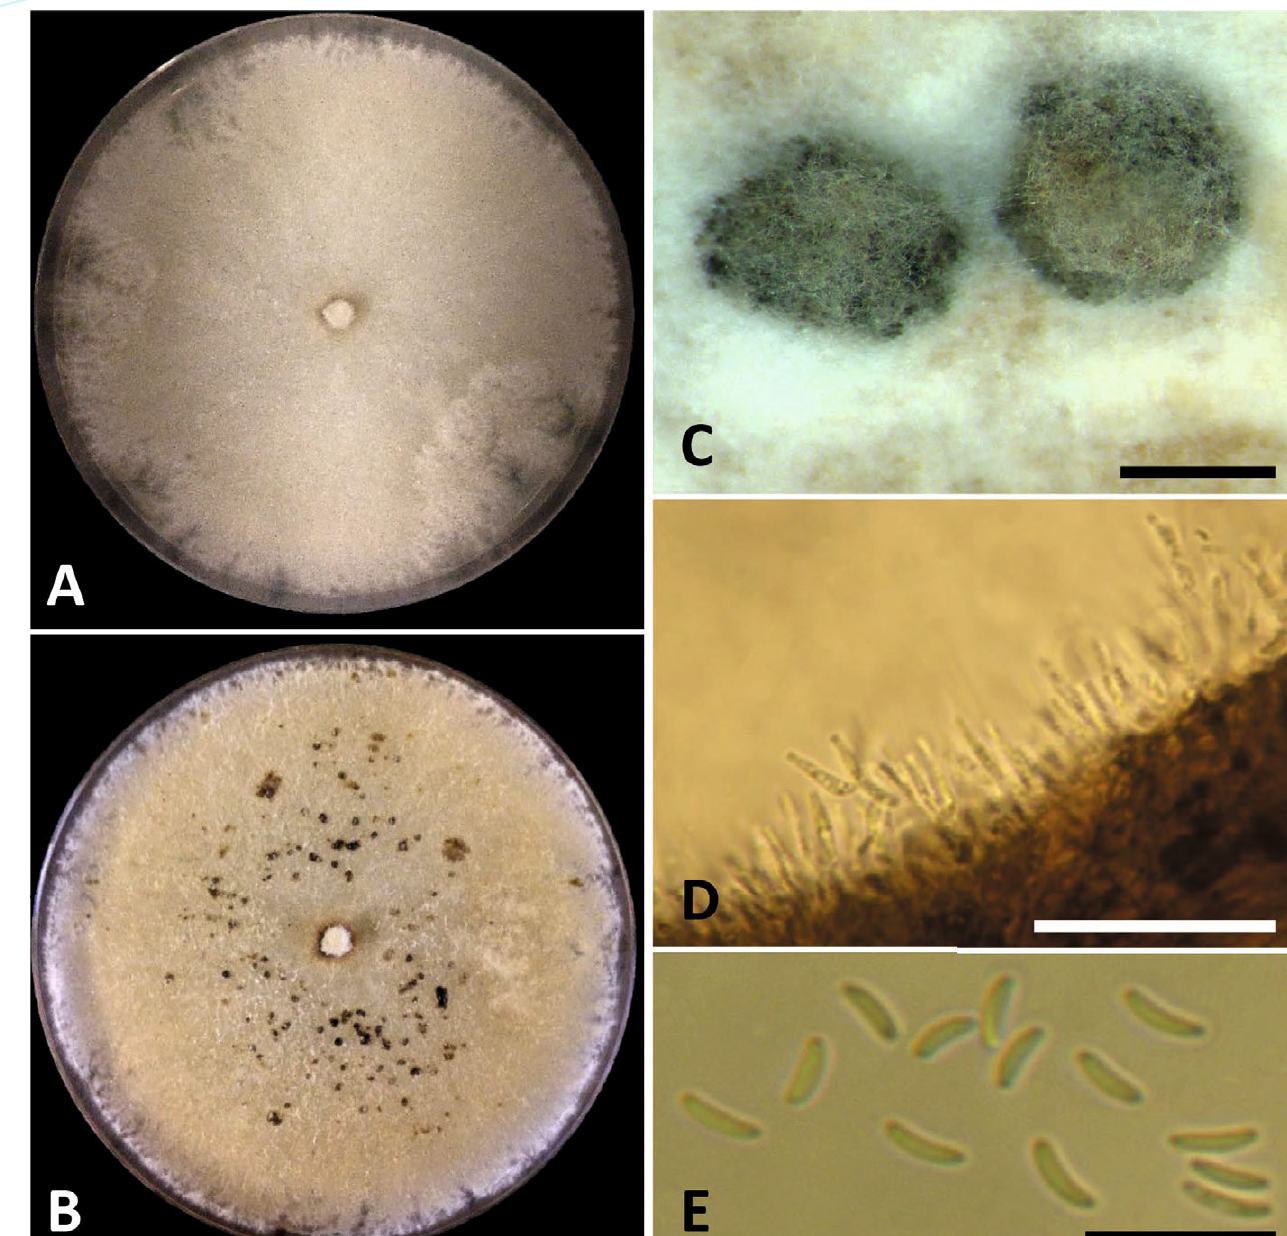
Fig. 7. Cytospora chrysosperma (CBS 144242). A. Seven-day-old PDA culture. B. Fourteen-day-old PDA culture. C. Pycnidia. D. Conidiophores (cid:9)(cid:17)(cid:21)(cid:2)(cid:20)(cid:23)(cid:9)(cid:6)(cid:13)(cid:17)(cid:8)(cid:4)(cid:5)(cid:7)(cid:2)(cid:19)(cid:4)(cid:17)(cid:11)(cid:21)(cid:11)(cid:4)(cid:25)(cid:13)(cid:17)(cid:4)(cid:5)(cid:7)(cid:2)(cid:19)(cid:13)(cid:23)(cid:23)(cid:7)(cid:28)(cid:2) E. Conidia. Bars C = 1 mm; D = 20 μm; E = 10